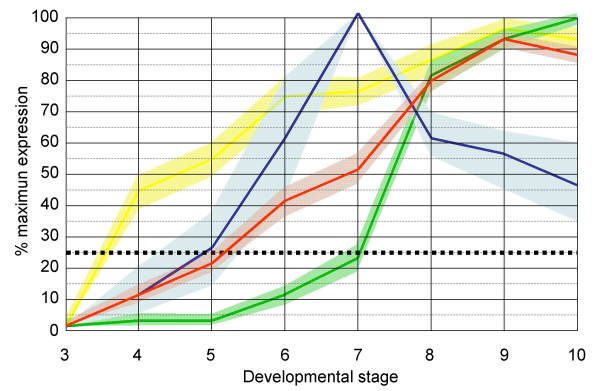
Expression profiles during seed development showing four different patterns of expression in the subtracted genes. Expression data are based on the microarray results [9]. Blue, pattern I; yellow, pattern IIa; red, pattern IIb; green, pattern IIc. Solid lines correspond to average expression and shaded areas to the standard errors. Developmental stages: 3, siliques with embryos at the mid-globular to early heart embryo stage; 4, siliques with embryos at the early to late heart-embryo stage; 5, siliques with embryos at the late heart to mid torpedo stages; 6, seeds with embryos at the late torpedo stage; 7, seeds with embryos at the late torpedo to early walking-stick stage; 8, seeds with embryos at the walking-stick to early curled-cotyledon stages; 9, seeds with embryos at the curled-cotyledon to early green-cotyledon stages; 10, seeds with embryos at the green cotyledon stage. The dotted line corresponds to 25% of the maximum expression.